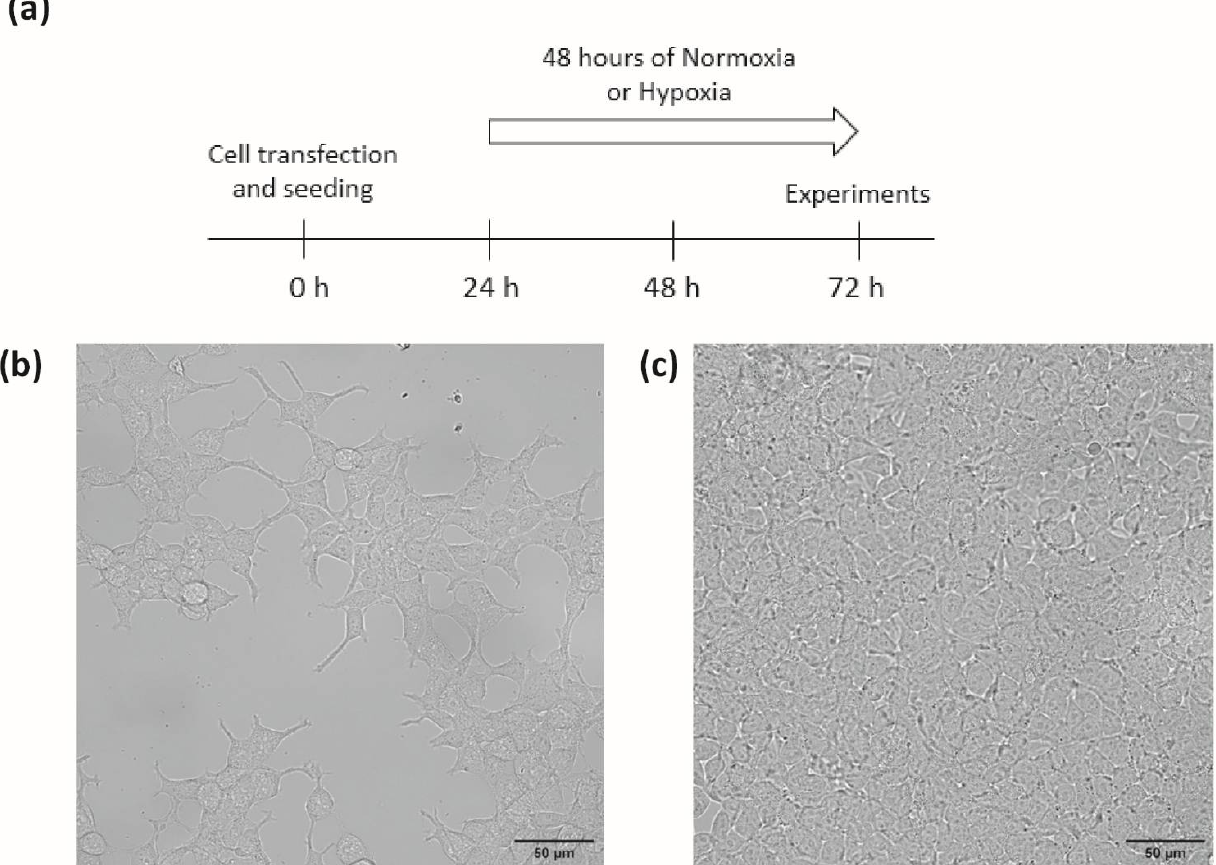
Figure 1. Cell culture conditions ( a ) timeline protocol for cell experiments, ( b , c ) representative phase-contrast fields of HEK293T cells seeded at ( b ) low (1 × 10 4 cells/cm 2 ) or ( c ) high (3 × 10 5 cells/cm 2 ) densities after 72 h of culture. Scale bar = 50 µm (magnification × 40).